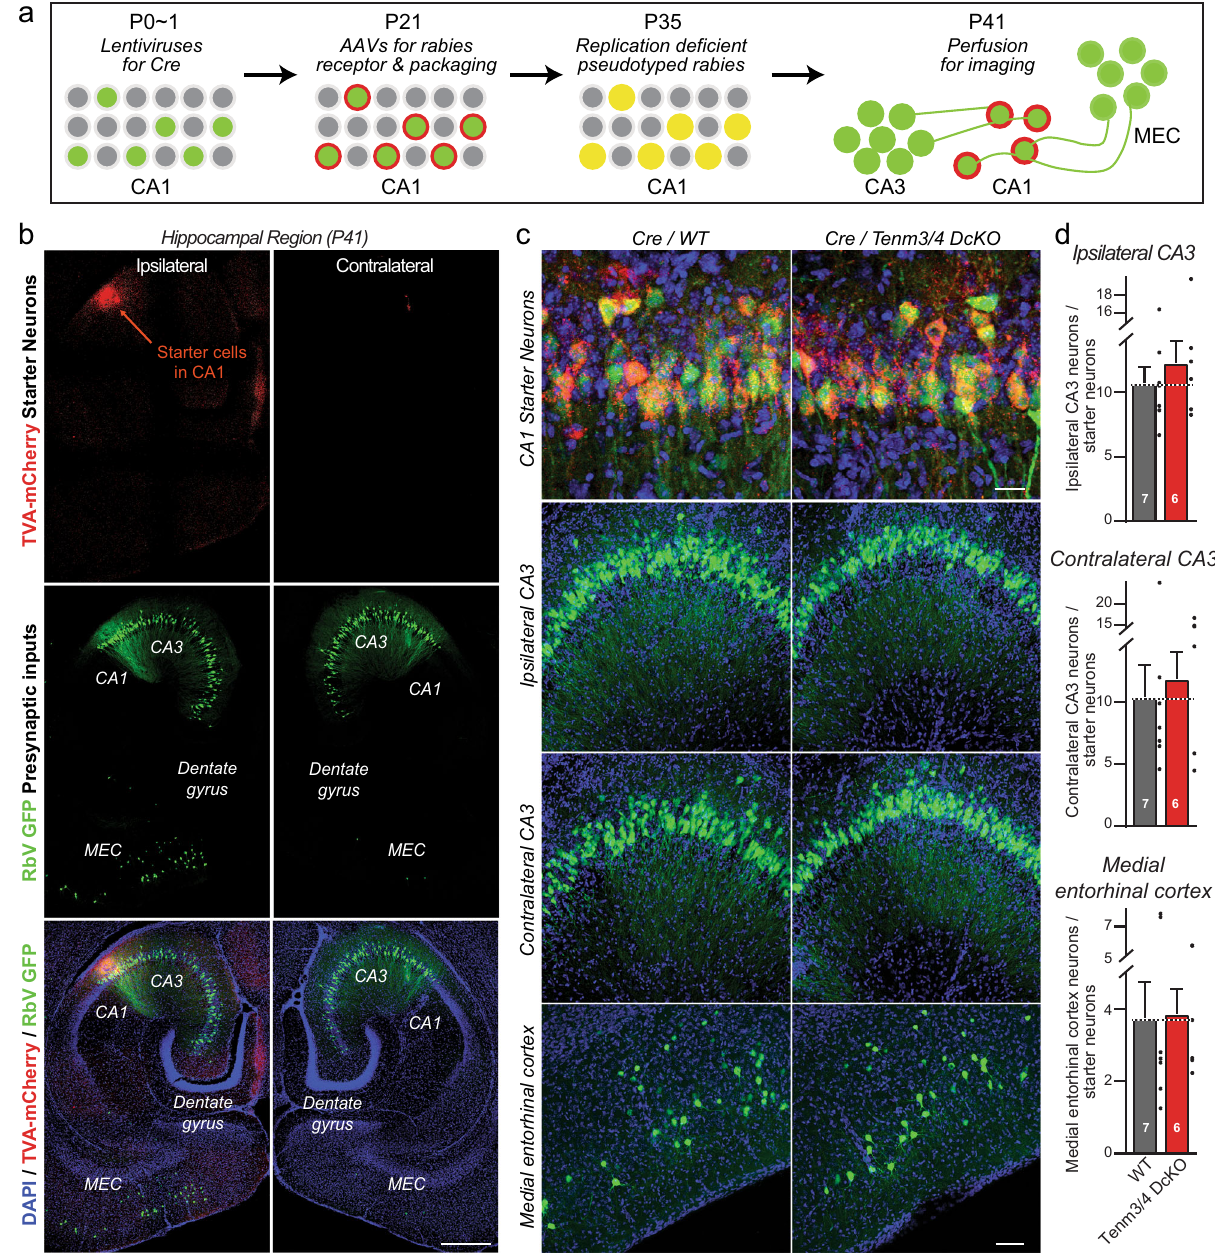
Fig. 7 Retrograde trans-synaptic pseudorabies virus tracing demonstrates that the postsynaptic deletion of Tenm3 and Tenm4 in CA1 region neurons has no effect on the formation of synapses on CA1 neurons. a Experimental strategy. The proximal CA1 neurons of WT or Tenm3/4 DcKO mice were sparsely infected unilaterally with lentiviruses encoding Cre-recombinase at P0. The same proximal CA1 neurons were then superinfected with AAVs encoding the Cre-dependent mCherry-tagged pseudorabies virus receptor and pseudorabies virus packaging proteins at P21, which are therefore only expressed in neurons containing Cre. Finally, the proximal CA1 was infected with pseudorabies viruses encoding eGFP at P35, and the ipsi- and contralateral hippocampal CA3 and the ipsilateral medial entorhinal cortex were analyzed by imaging at P41. Postsynaptic ‘ starter ’ neurons in the tracing experiments are double-positive for both mCherry and eGFP, whereas presynaptic input neurons are positive only for eGFP. b Representative images of a pseudorabies virus tracing experiment in the hippocampal formation (red, starter neurons expressing the mCherry-tagged pseudorabies virus receptor; green, eGFP-positive neurons containing pseudorabies viruses). c Representative higher resolution images of retrograde trans-synaptic tracing experiments in control mice (left images) and mice with a postsynaptic deletion of Tenm3/4 (right images). Images show starter neurons (top), ipsi- and contralateral presynaptic CA3 region input neurons (middle rows), and ipsilateral MEC input neurons (bottom). d Quanti fi cations of presynaptic inputs onto postsynaptic proximal CA1 neurons as a function of the postsynaptic Tenm3/4 deletions show that postsynaptic Tenm3 and Tenm4 are not required for normal synaptic connections formed by MEC and CA3 neurons onto CA1 neurons. Data are means ± SEM; numbers of mice are indicated in the bars. Statistical signi fi cance was assessed using two-sided Student ’ s t-test (non signi fi cant comparisons are not indicated). Scale bars: 0.5 mm ( b ), 20 µ m ( c , top panel) and 100 µ m ( c , bottom three